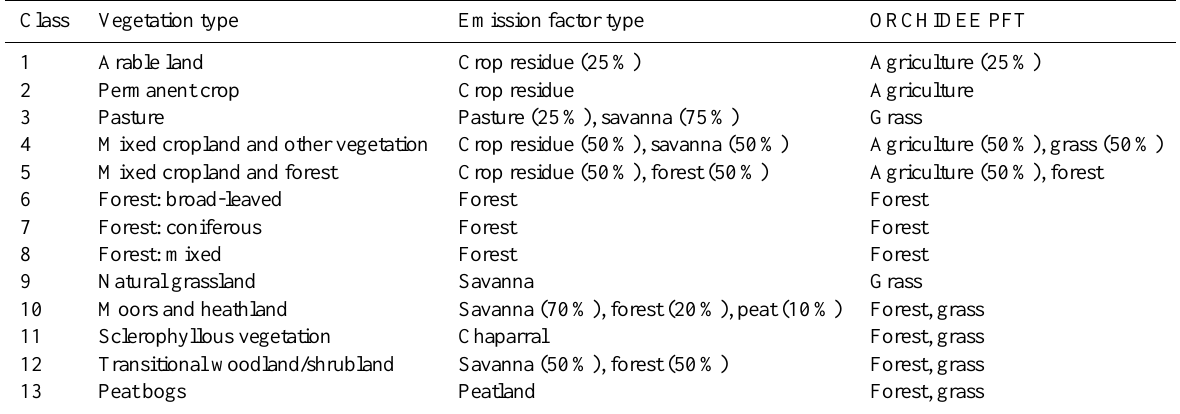
Table 1. Land cover categories in the CORINE land cover, and corresponding general ecozone and ORCHIDEE PFT. The applied weight is indicated in parentheses if different than